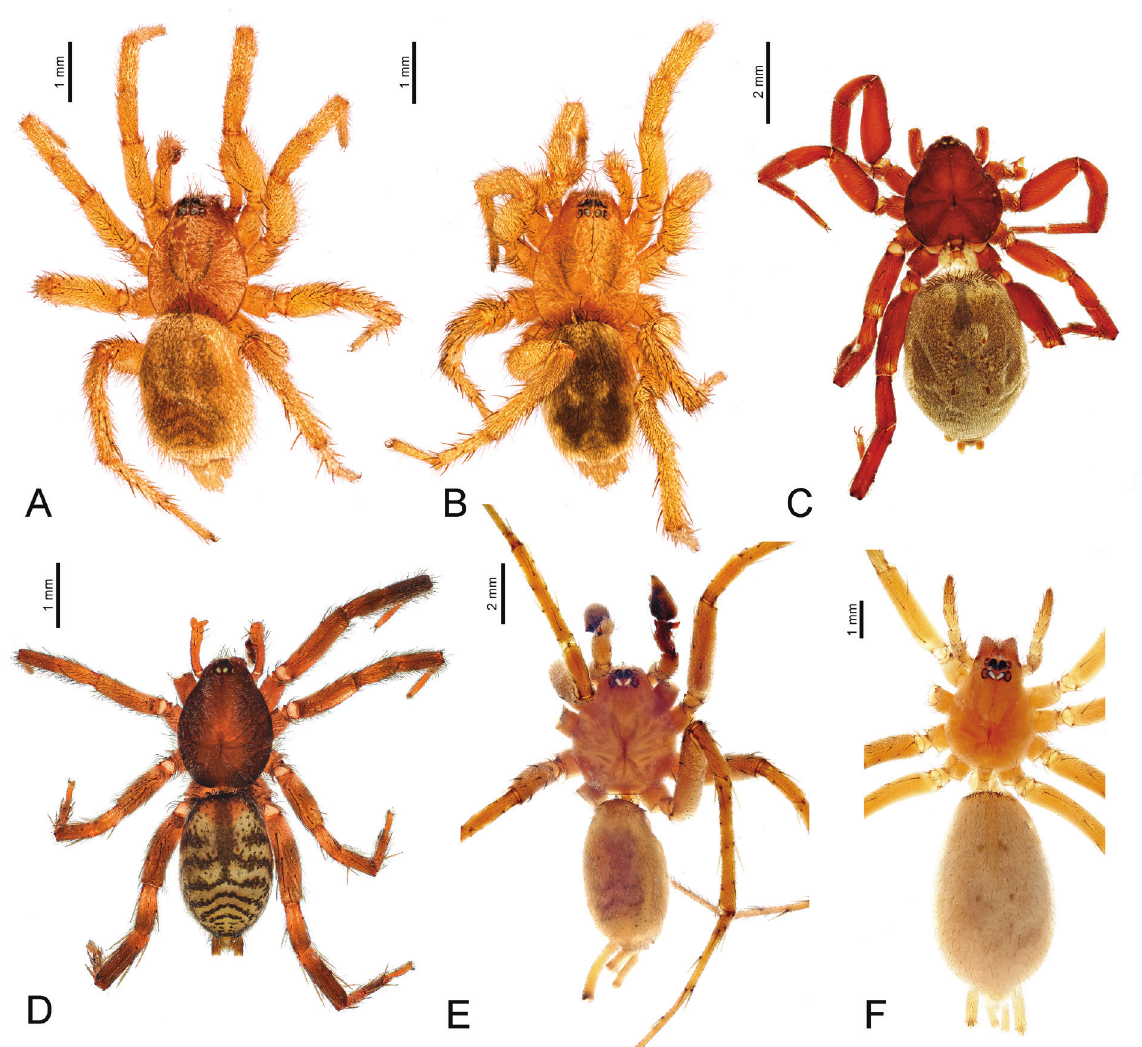
Figure 1. Habitus of male ( A, D, E ) and female ( B, C, F ) gnaphosids, dorsal view. A, B. Minosiella intermedia Denis, 1958; C. Marinarozelotes jaxartensis (Kroneberg, 1875); D. Odontodrassus aravaensis Levy, 1999; E. Pterotricha dalmasi Fage, 1929; F. Pterotricha kovblyuki Zamani & Marusik, 2018.